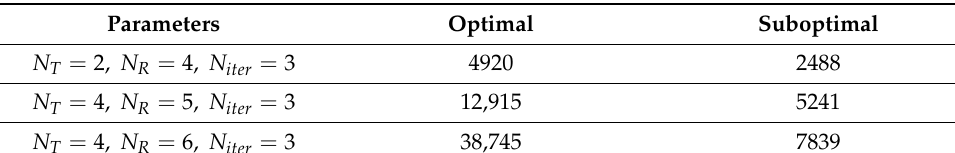
Table 1. Complexity of RMs plus RSs.